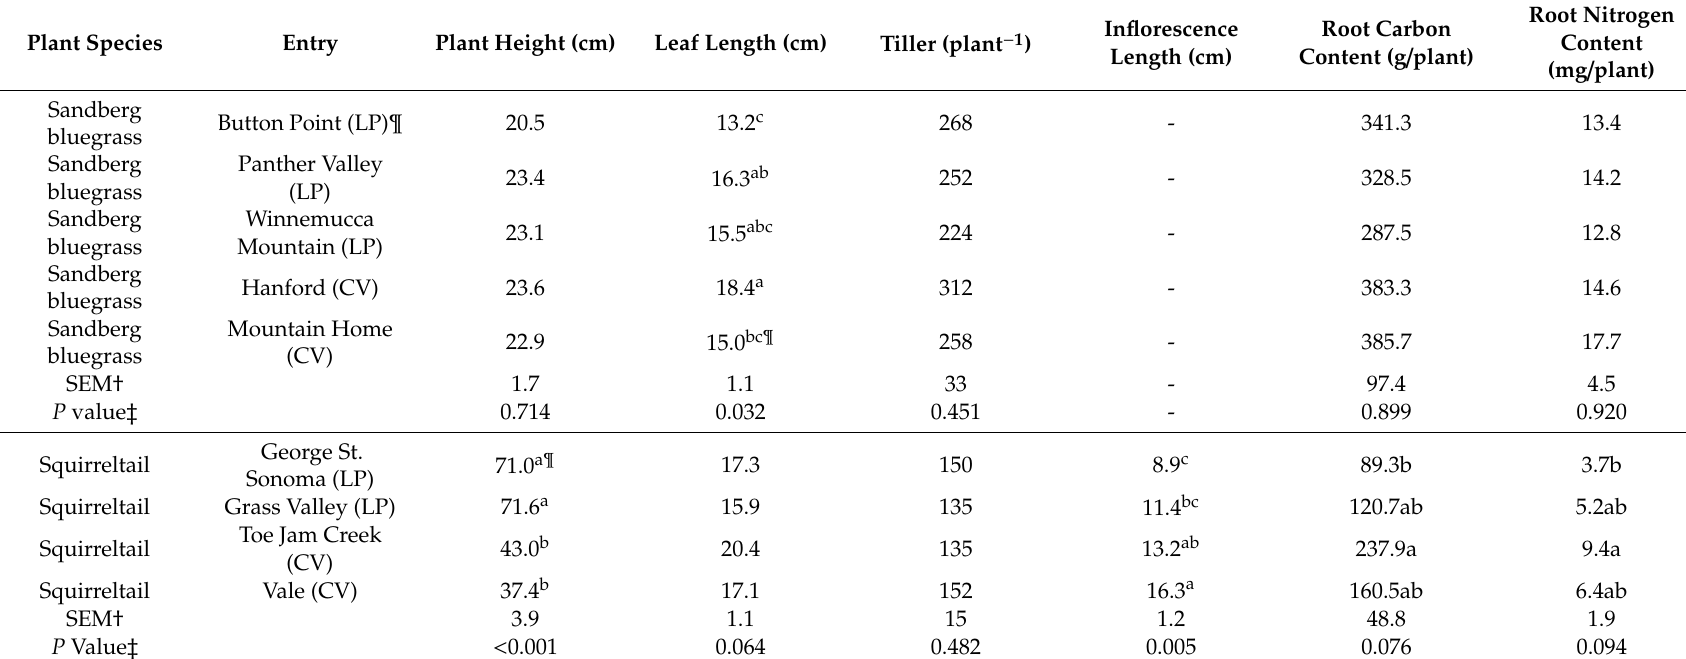
Table 1. Plant height, leaf length, tillers per plant, inflorescence length, root carbon, and nitrogen content of Sandberg bluegrass and Bottlebrush squirreltail populations grown under greenhouse conditions at the University of Nevada, Reno